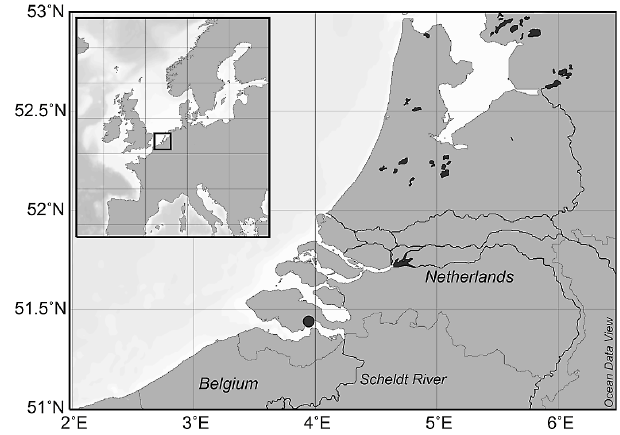
Fig. 1. Map of the study area. Black circle indicates sampling